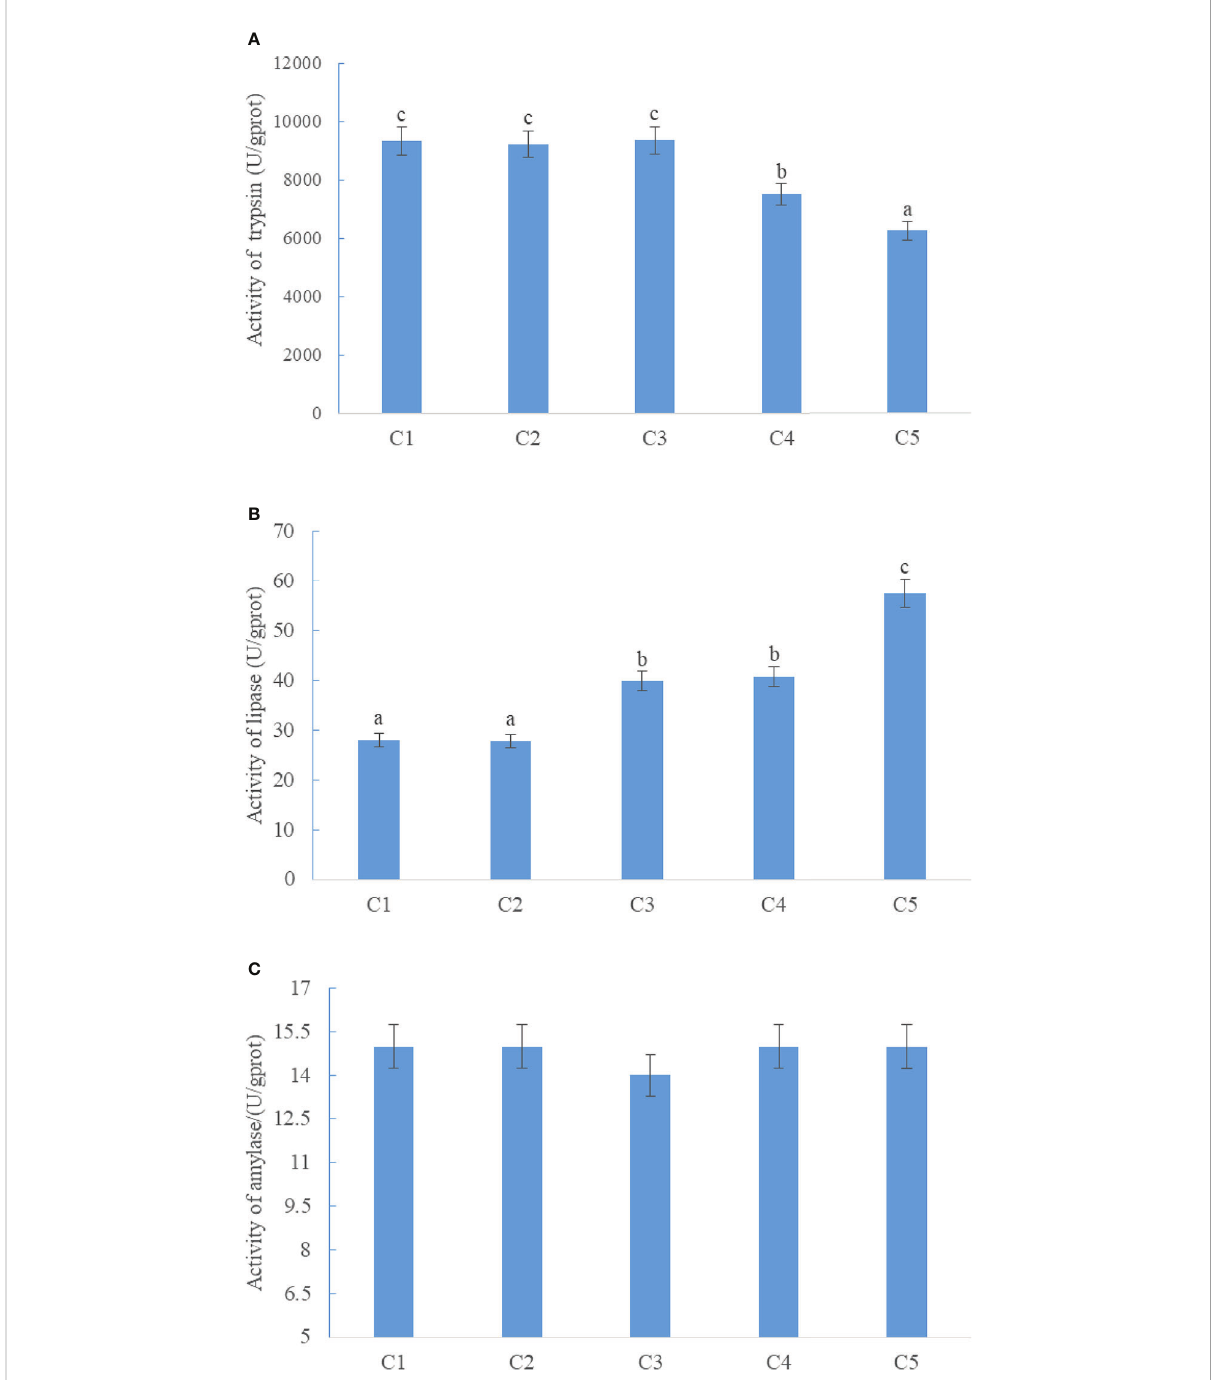
FIGURE 1 Effects of fi shmeal replacement by cottonseed protein concentrate on the activity of intestinal trypsin (A) , lipase (B) , and amylase (C) in rainbow trout (Mean ± S.E.). Different letters on the bar chart indicate signi fi cant difference ( P <